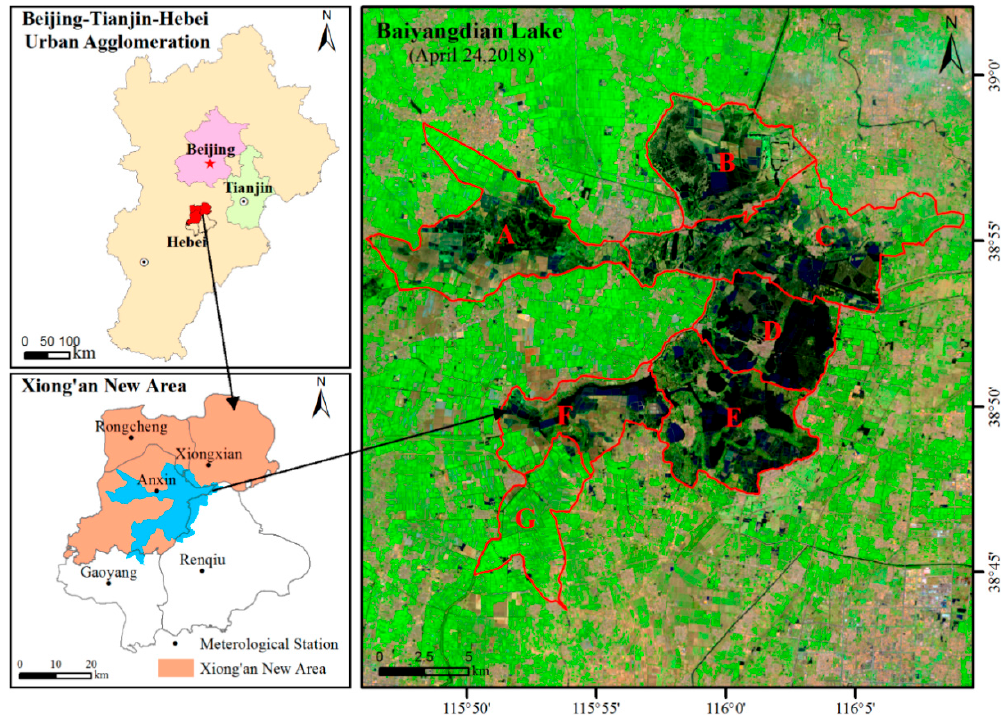
Figure 1. Location of the study area (the remote sensing image of Baiyangdian Lake is displaced by false color images and using bands 7, 5 and 3).